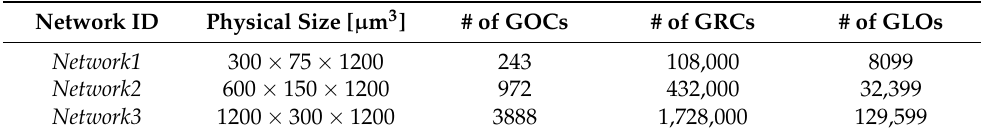
Table 3. Features of the simulated granular layer